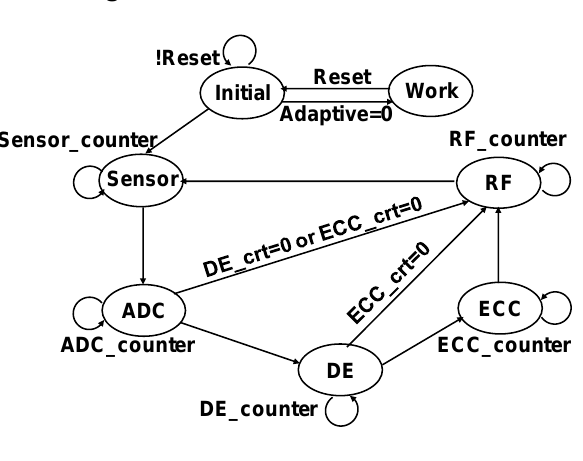
Figure 2. Main FSM of the